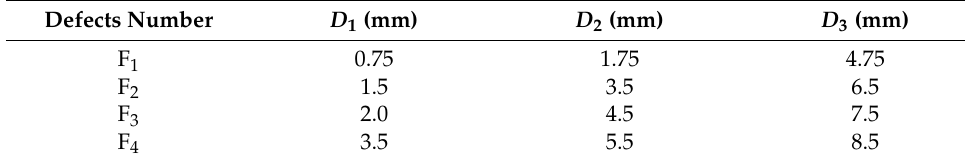
Figure 7. The PCB specimen for testing the performance of the EC probe in determining crack orientation: ( a ) photograph of the PCB with defects, and ( b ) illustration for the orientation angles of the defects with the defect numbers. Table 2. Geometrical Characteristic of Machined Holes on